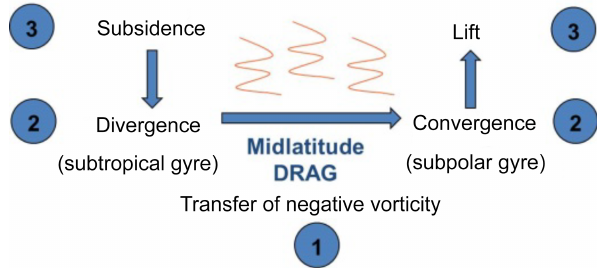
Figure 18. Schematics of proposed residual circulation in the mid- latitudes: additional midlatitude drag would correct for (1) the zonal, meridional and stress curl errors, and (2) the wind divergence errors, and (3) close the circulation by vertical